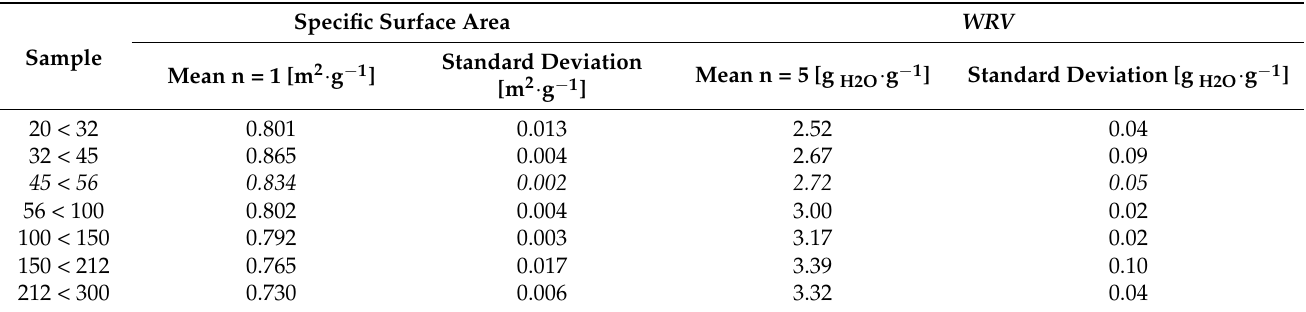
Table 2. Results of specific surface and WRV measurements.